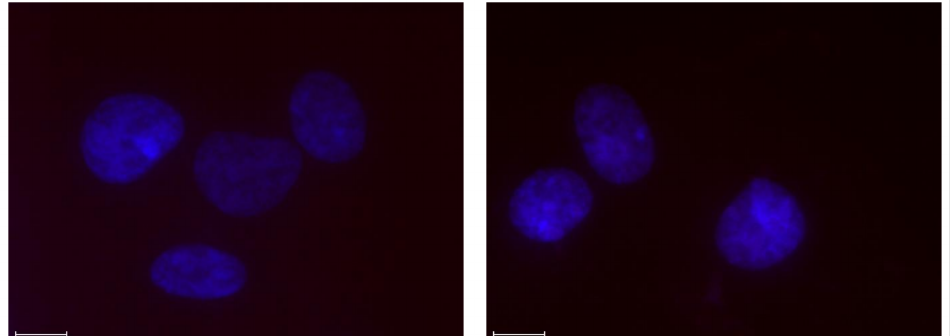
Figure 7. Images from d-FISH experiments in which INV2 (left panel) and INV10 (right panel) were incubated with fixed isolated female bovine endothelial nuclei. Note the absence of Cy3 signals. Incubation conditions and the image capture process were as described in Figure 6. Data previously shown in [23]—reproduced with permission from the Royal Society of